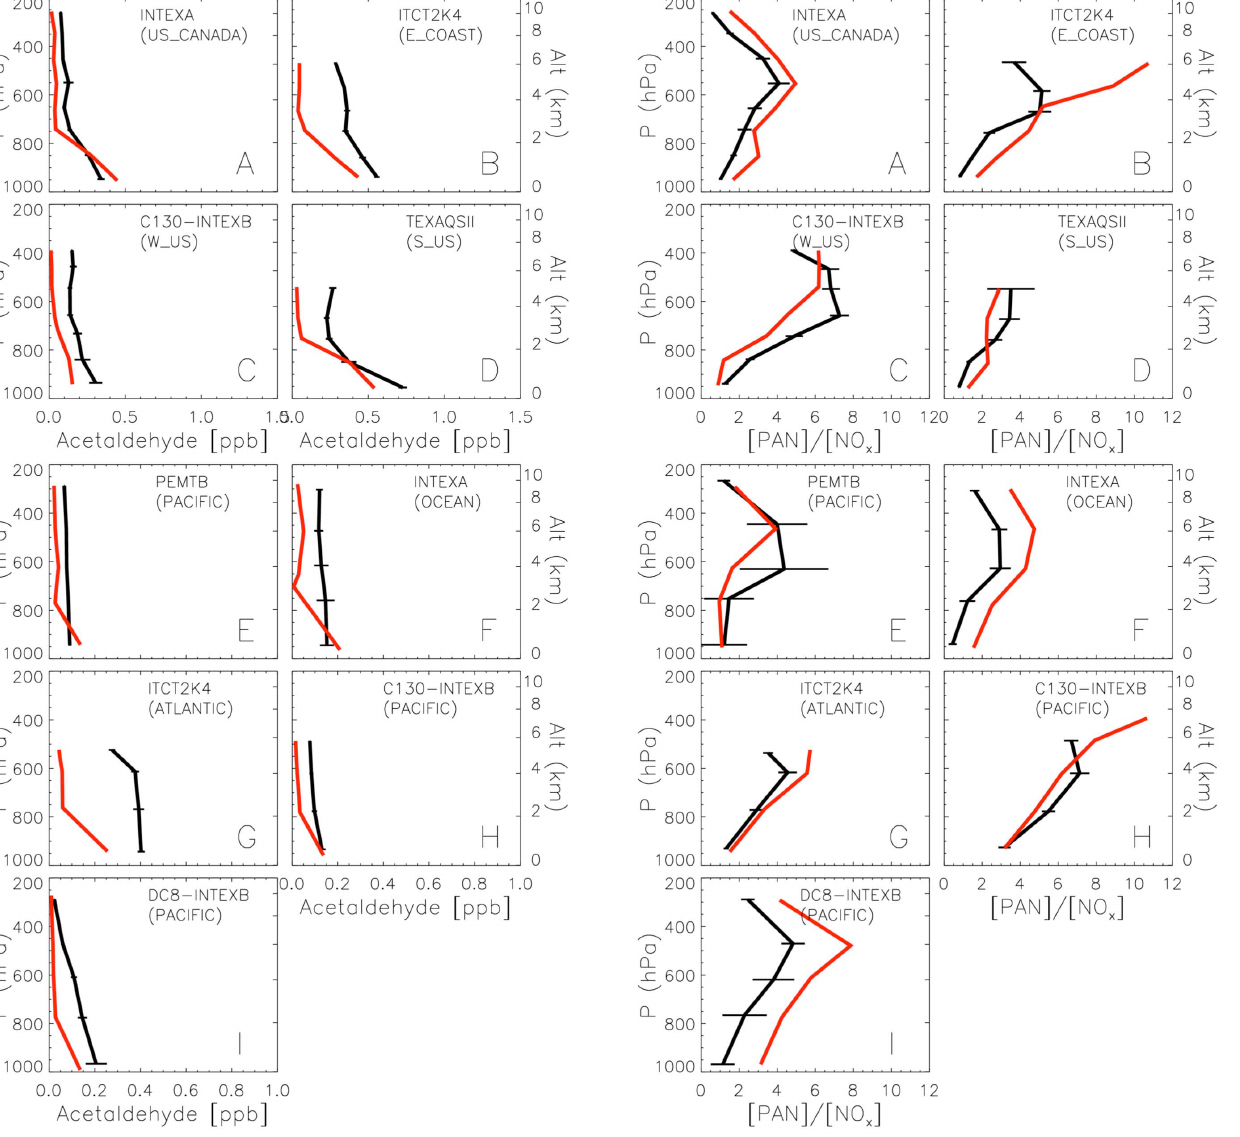
Fig. 10. Vertical profiles of acetaldehyde mixing ratio over the North American continent (A–D) and over the ocean (E–I) . Air- craft measurements are shown in black with the error bars indicat- ing twice the standard error around the mean for each altitude bin. Red lines show the GEOS-Chem simulated profiles with the model sampled at the same time and day of year as the observations. Note the differing x-axis scales for the land and ocean profiles. See text for details.